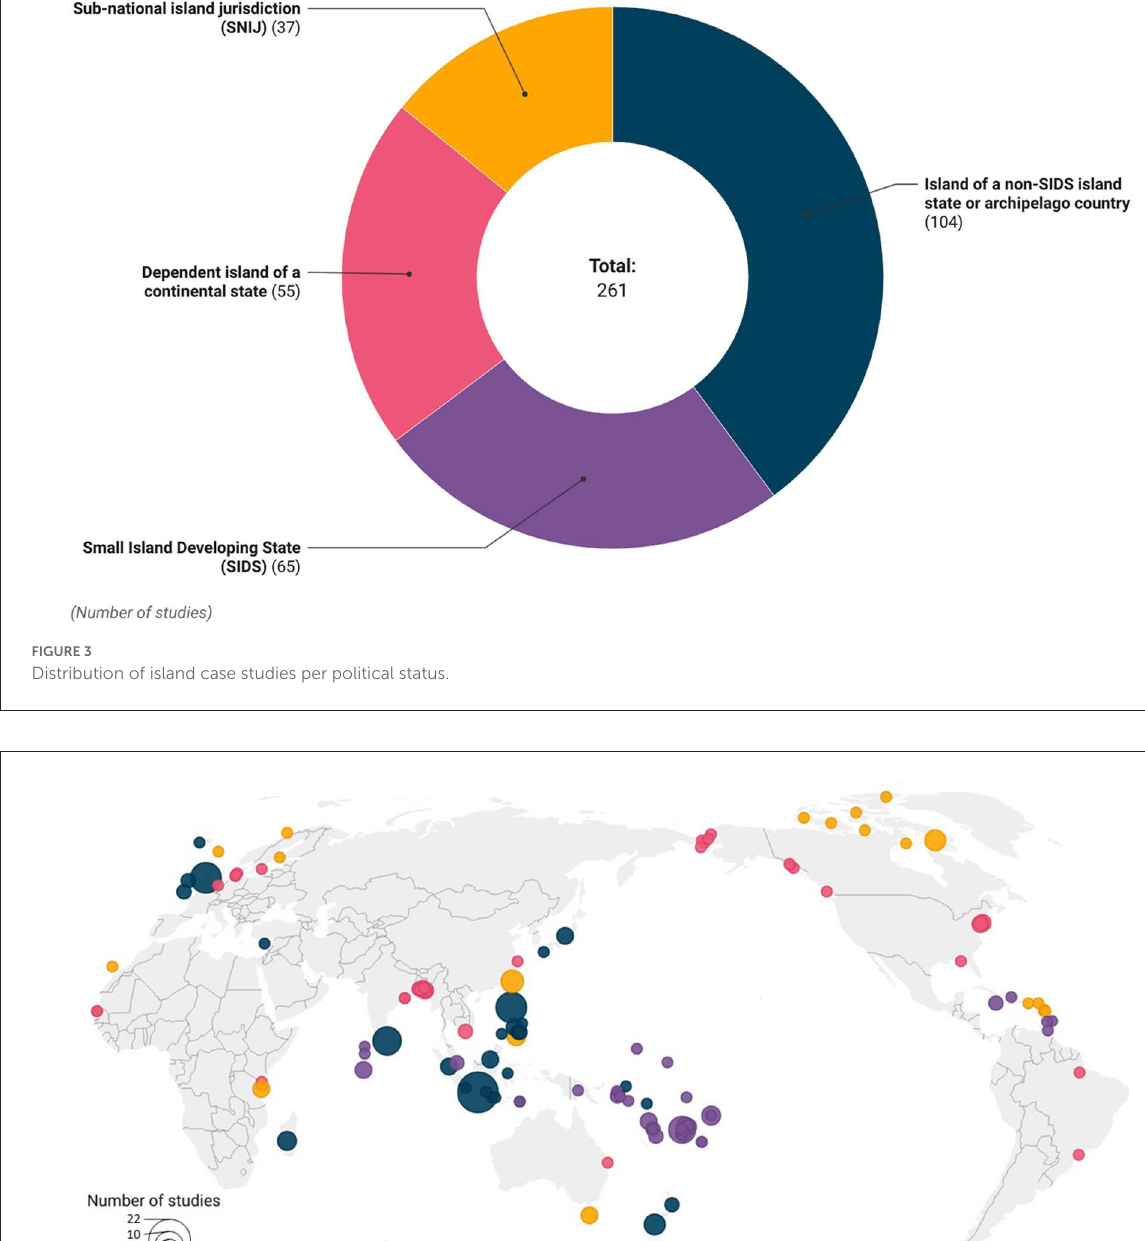
the central island of the SNIJ Nunavut (Canada). In SIDS, the majority of studies are located on peripheral islands. Many of the SIDS studied are larger archipelagos, such as Fiji and